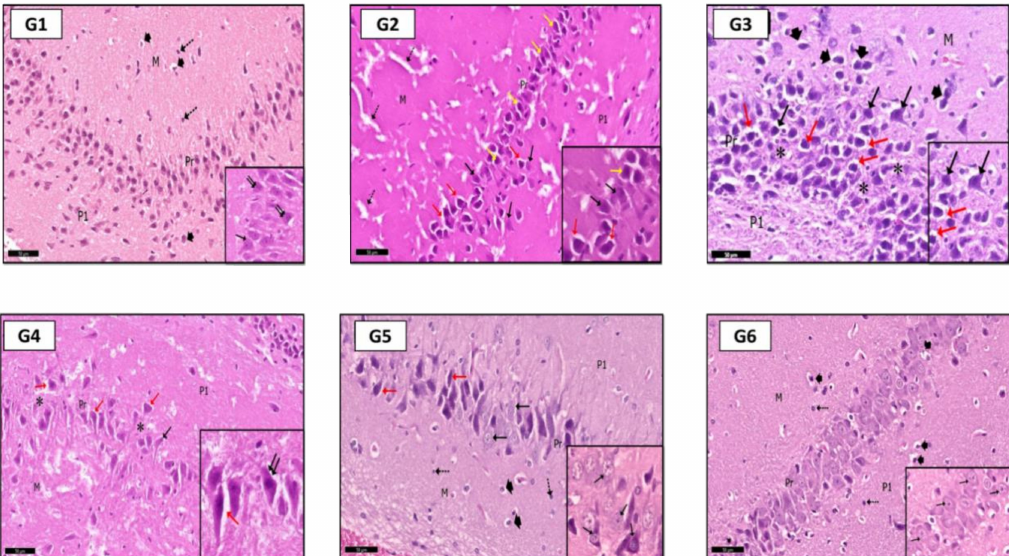
Figure 6. Photomicrographs of CA3 area of rat hippocampus shows: in control rats ( G1 ), CA3 area consists of three layers; molecular (M), pyramidal (Pr), and polymorphic (P1) layers. The pyramidal cells are large neurons with rounded vesicular nuclei ( ↑ ), some of them are binucleated (inset— ↑↑ ). Molecular layer (M) has a loose appearance with glial cells (head arrow) and interneurons (dot arrow). In ( G2 ) (PILO rats), signs of degeneration were evident, especially in pyramidal layer in the form of shrunken pyramidal cells with pyknotic nuclei (yellow ↑ ) with wide perineuronal spaces (red ↑ ; some pyramidal cells have karyolitic nuclei (black ↑ ). Notice pale vacuolated areas (dot ↑ ) in molecular layer (M) and Polymorphic (P1) layer. In ( G3 ) (PILO+LPS rats) higher degree of cellular degeneration was recorded with empty spaces (*), pyknotic nuclei (black ↑ ), shrunken neurons with perineuronal spaces (red ↑ ) within pyramidal layer (see also inset). Molecular layer (M) shows a marked enlargement of glial cells (head arrow). In ( G4 ) (PILO+LPS+VPA rats), few shrunken pyramidal cells (black ↑ ) with perineuronal spaces (red ↑ ) within pyramidal layer (Pr); areas of pyramidal cells loss were localized (*). Inset: higher magnification of pyramidal cells. In ( G5 ) (PILO+LPS+Celecoxib rats), moderate signs of improvement were recorded in most of pyramidal cells (black ↑ ); shrunken cells with perineuronal spaces (red ↑ ) were rare; glial cells (head arrow) and interneurons (dot ↑ ) in molecular (M) and polymorphic layers (P1). In ( G6 ) (PILO+LPS+VPA+Celecoxib rats), cellular profile was nearly as in control rats, glial cells (head arrow), interneurons (dot ↑ ) and pyramidal cells appear with vesicular nuclei ( ↑ ). Insets are magnifications of pyramidal layer. Stain: H&E. Bar: 50 µ m. Inset ×